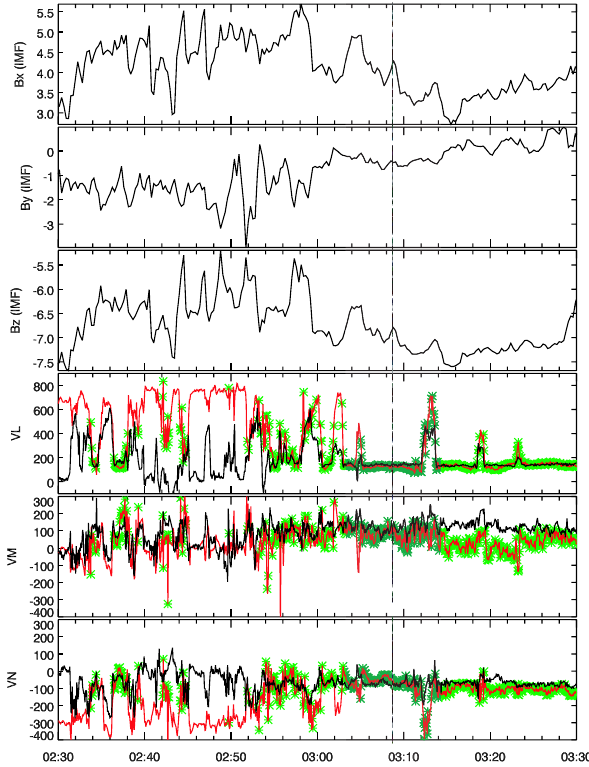
Figure 8 Fig. 8. Comparison between the predicted ion bulk flow velocity